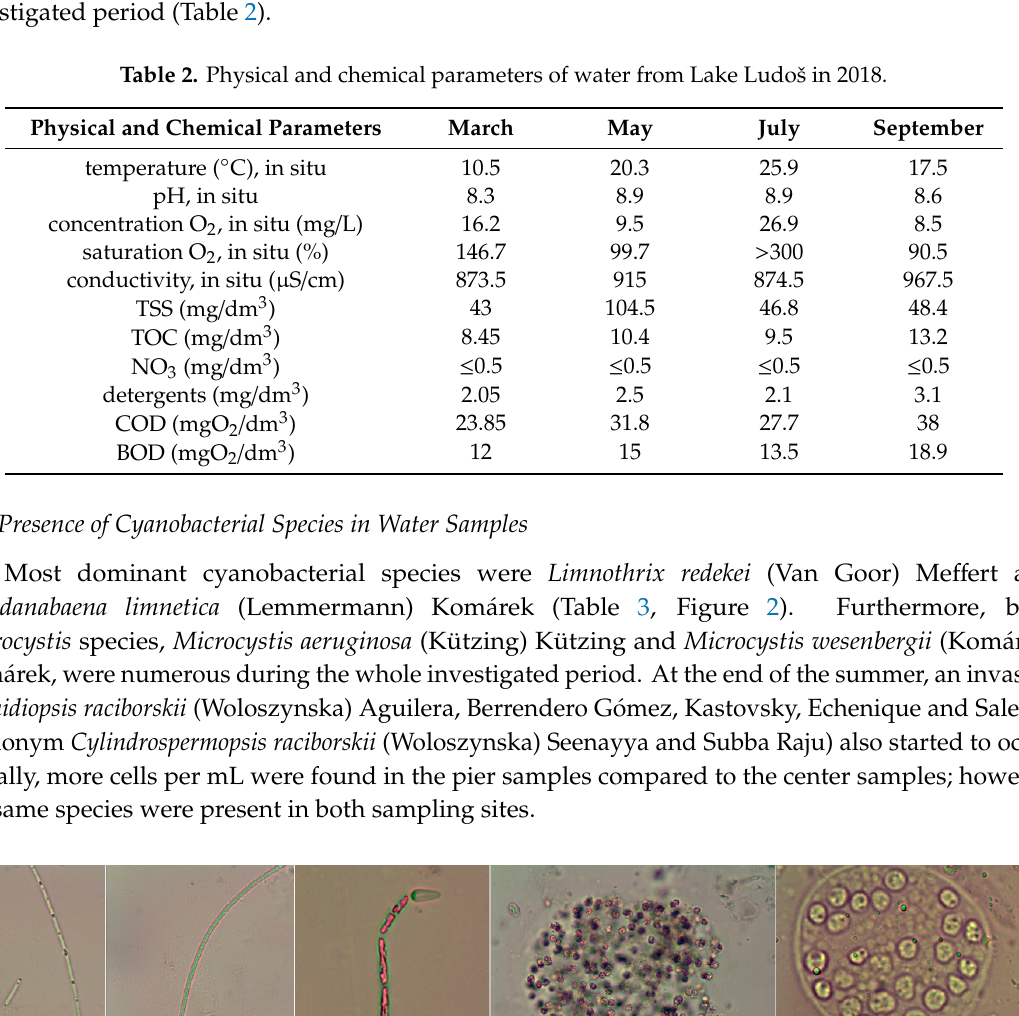
Table 4. The prevalence of mcyE, sxtA, sxtG, sxtS, cyrJ and anaC PCR products in Lake Ludoš.